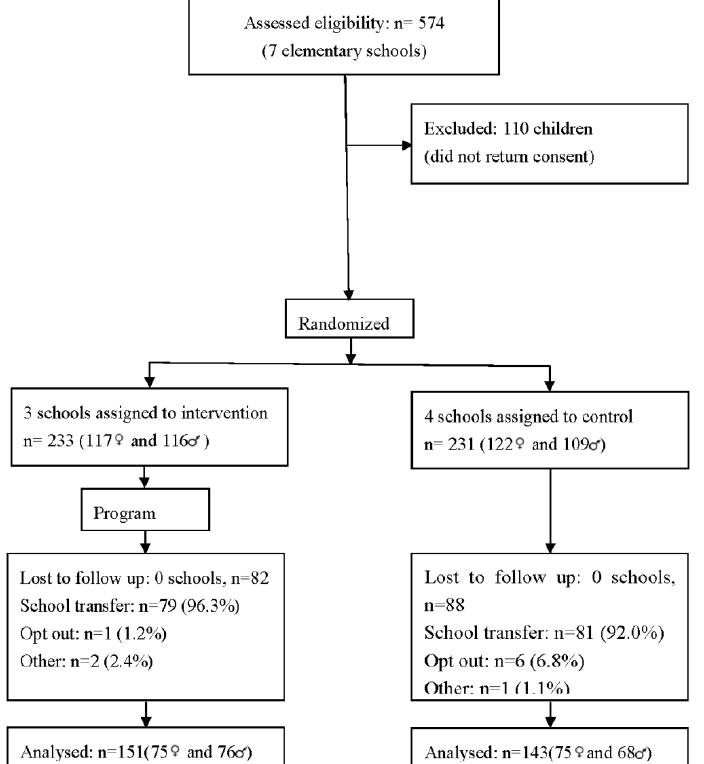
Figure 1. Flow of participants through each stage of the